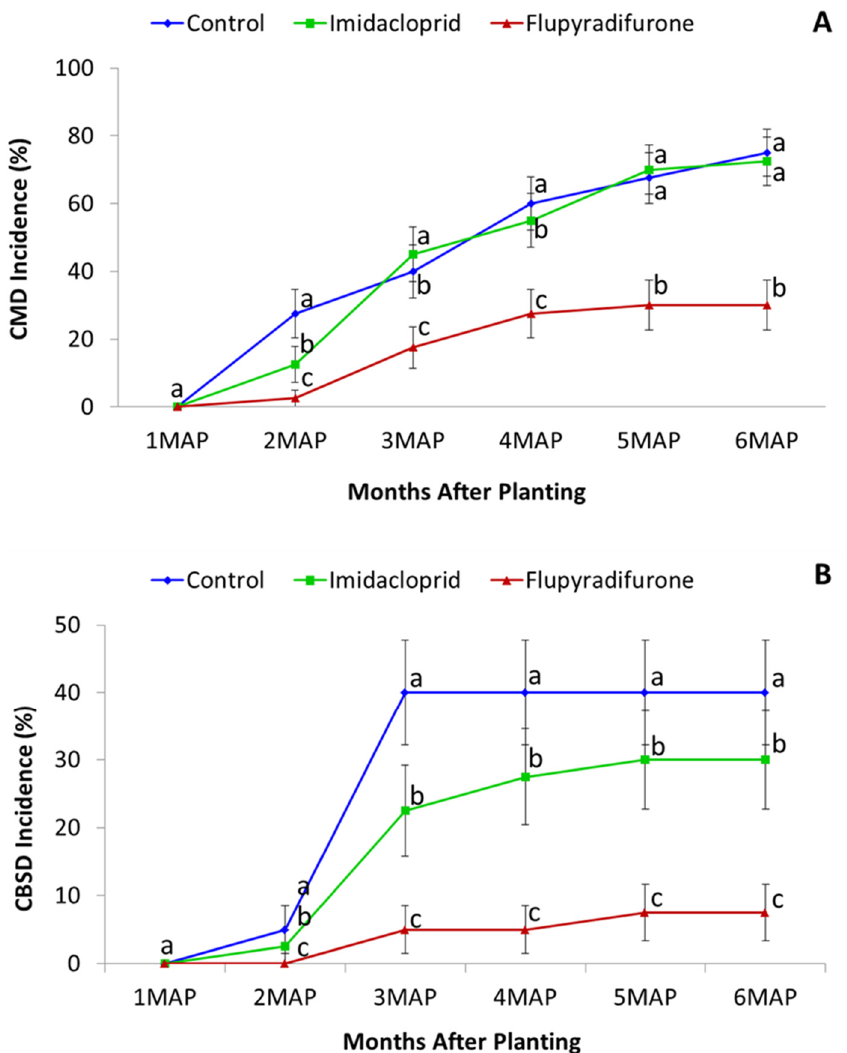
Figure 5. Cassava mosaic disease incidence for cutting dip treatments (flupyradifurone and imidacloprid) of variety Albert ( A ) and cassava brown streak incidence of variety Mkuranga1 ( B ). MAP—Months after planting (Means ± SE). Means with same letter within MAP are not significantly different ( p < 0.05, Tukey–Kramer).